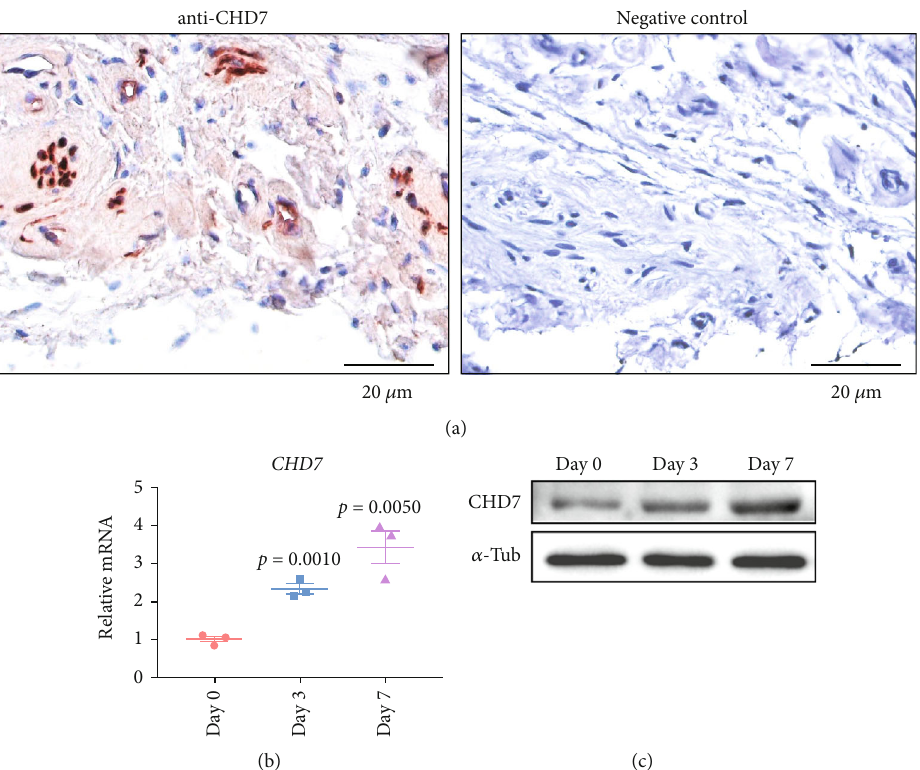
Figure 1: The high expression of CHD7 in hDFCs after osteoinduction. (a) Immunohistochemical staining images unraveled that CHD7 is present in human dental follicle. Scale bar, 20 μ m. (b), (c) qRT-PCR and Western blot unraveled that the expression of CHD7 increased after 3-day and 7-day